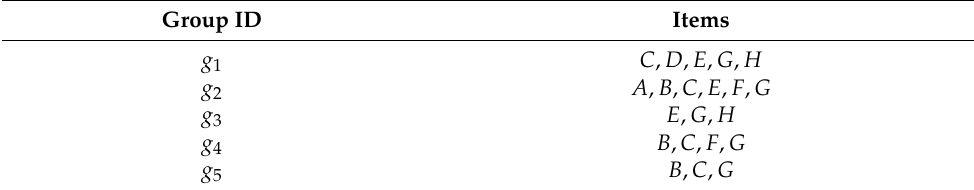
Table 1. Sample data set D, organized in groups and items.